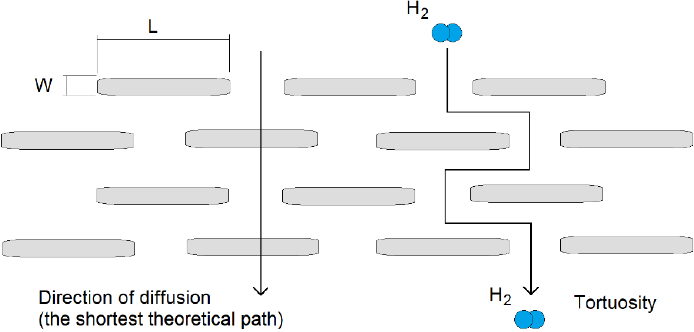
Figure 1. Tortuosity effect in hydrogen diffusion process.